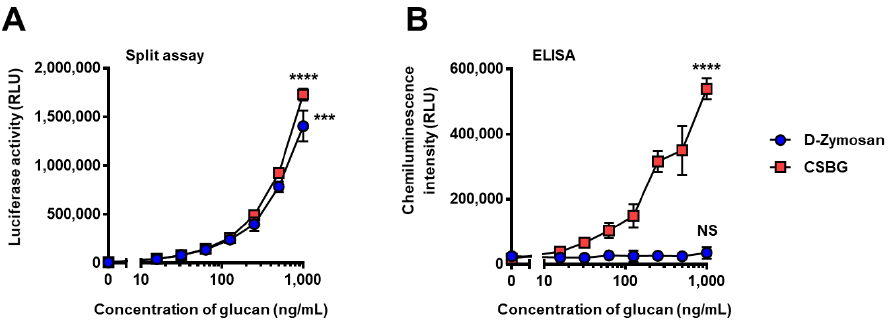
Figure 7. Comparison of split-NanoLuc assay and ELISA for detecting soluble and insoluble β- glucans. ( A ) Response to the split-NanoLuc complementation assay. The mixture solution of supBGRP-LgBiT and Neg1-E321Q-SmBiT (200 nM each, 5 µ L) was incubated with 10 µ L of depleted zymosan (D-Zymosan) suspension or CSBG solution (0–1000 ng/mL, each). After 30 min, 15 μL of furimazine solution were added and NanoLuc activity measured. ( B ) Response to the HRP-based ELISA method. D-Zymosan suspension and CSBG solution (0–1000 ng/mL) bound to a plate coated with supBGRP-LgBiT were detected using Neg1-E321Q-biotin and streptavidin-HRP with a chemiluminescence substrate. Data are presented as the mean ± SD ( n = 4) and are representative results from at least two independent experiments. Significant differences between blank and the highest concentration (1000 ng/mL) are indicated as *** p < 0.001; **** p < 0.0001; NS: not signifi- cant.